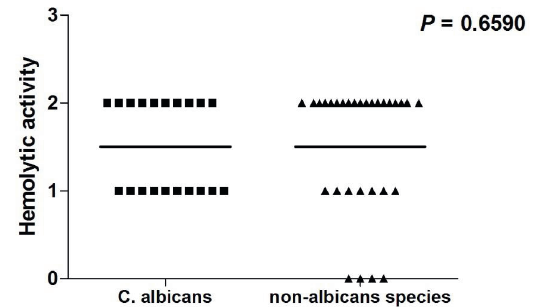
Figure 1 - Values and medians of hemolytic activity observed for C. albicans and non- albicans species ( p = 0.6590).